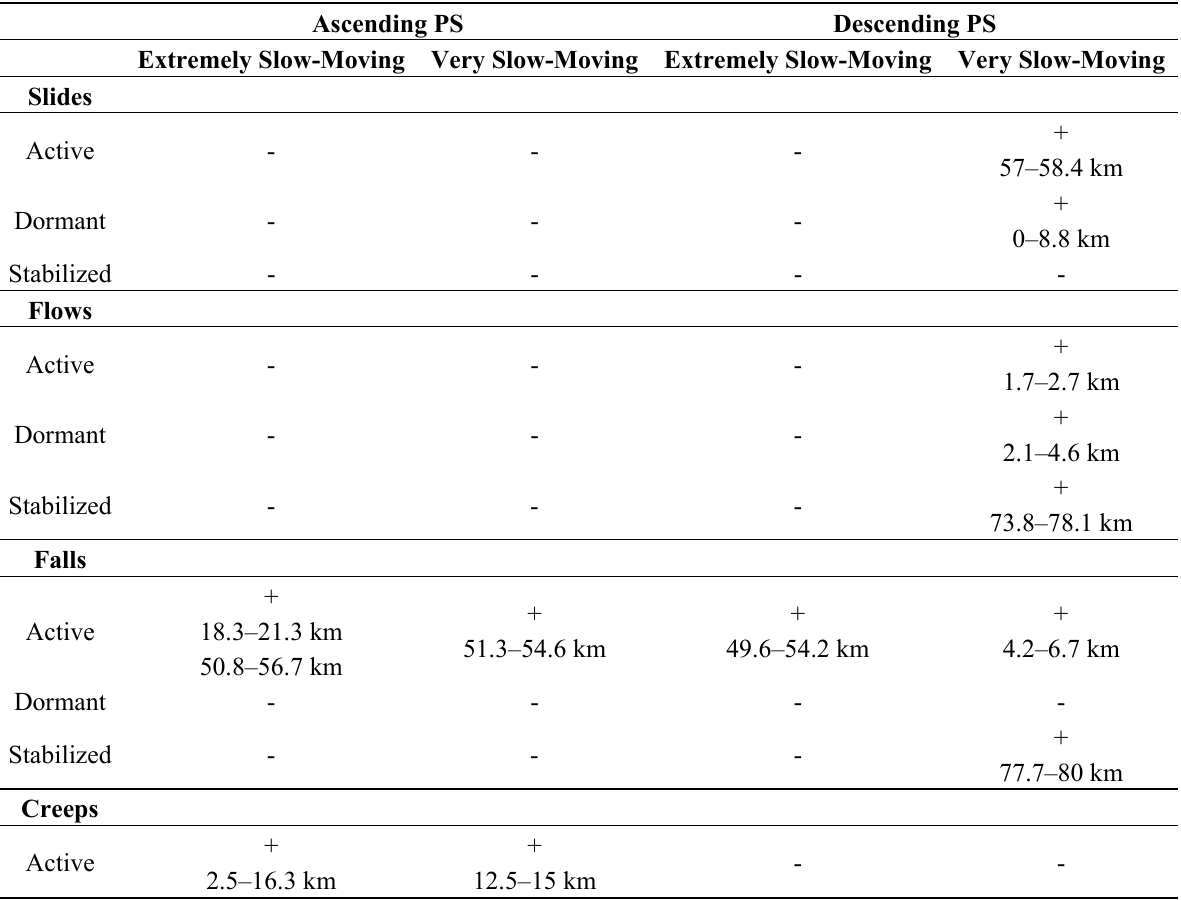
Table 4. The results of the bivariate K-function analysis showing spatial clustering or independence between PSI point targets and landslide occurrences. Ascending PS Descending PS Extremely Slow-Moving Very Slow-Moving Extremely Slow-Moving Very